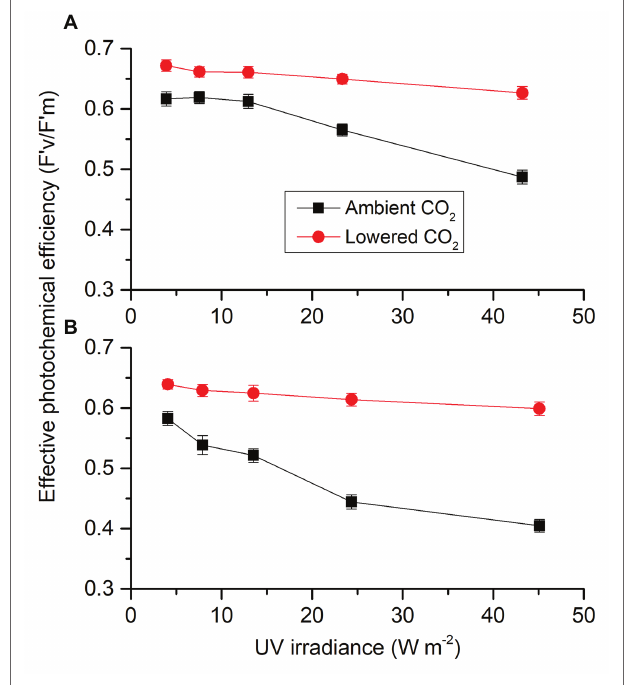
FIGURE 7 | Effective photochemical efficiency (F' v /F' m ) of S. costatum cultured at ambient (A) and lower CO 2 (B) levels exposed to different radiation treatments. PAR, photosynthetically active radiation; PA, PAR + UVA, PAB, PAR + UVA + UVB. The error bars indicate the SDs ( n = 3).